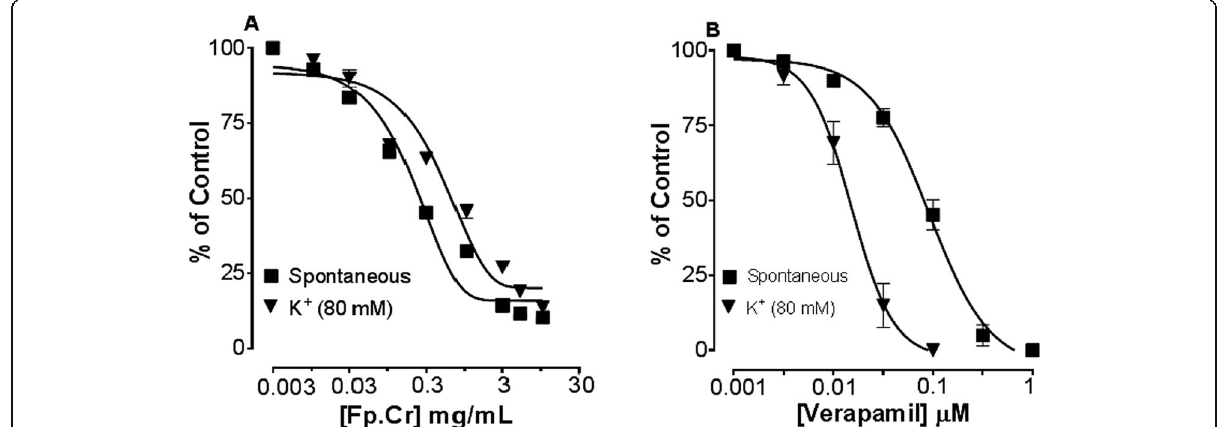
Fig. 4 Dose-dependent inhibitory effect on spontaneous and K + (80 mM) induced contractions of ( a ) Ficus palmata crude extract (Fp.Cr) and ( b )